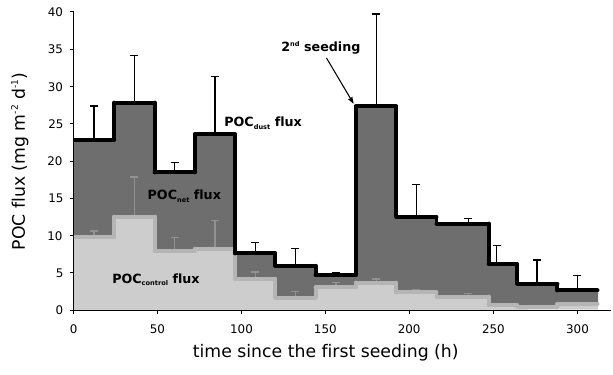
Fig. 1. Temporal evolution of the POC dust flux (black line), the POC control flux (light-gray portion), and the POC net flux (dark-gray portion). Data represents the average (+SD) of the three replicate